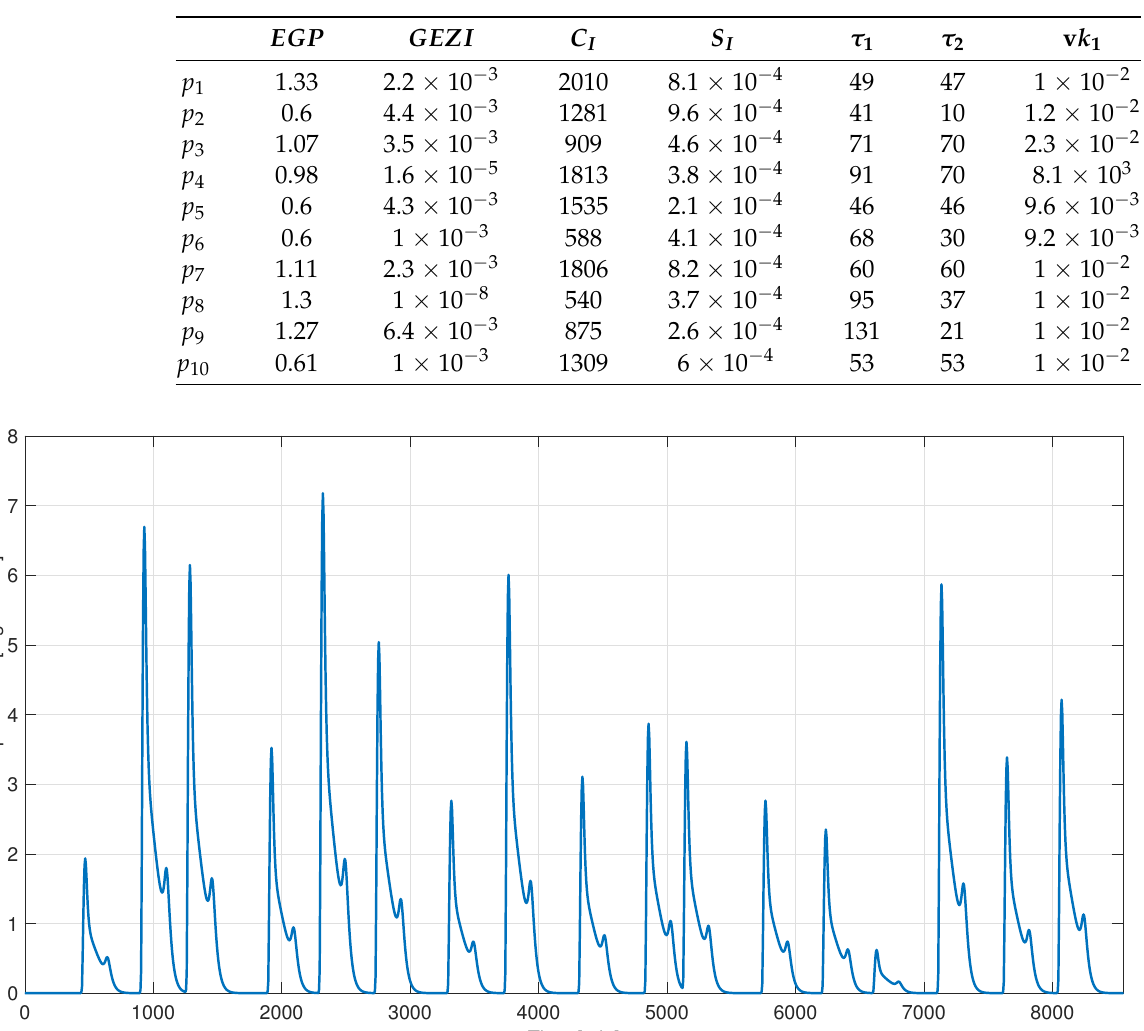
Table 2. Parameters of the virtual patients, associated with the IVP model.